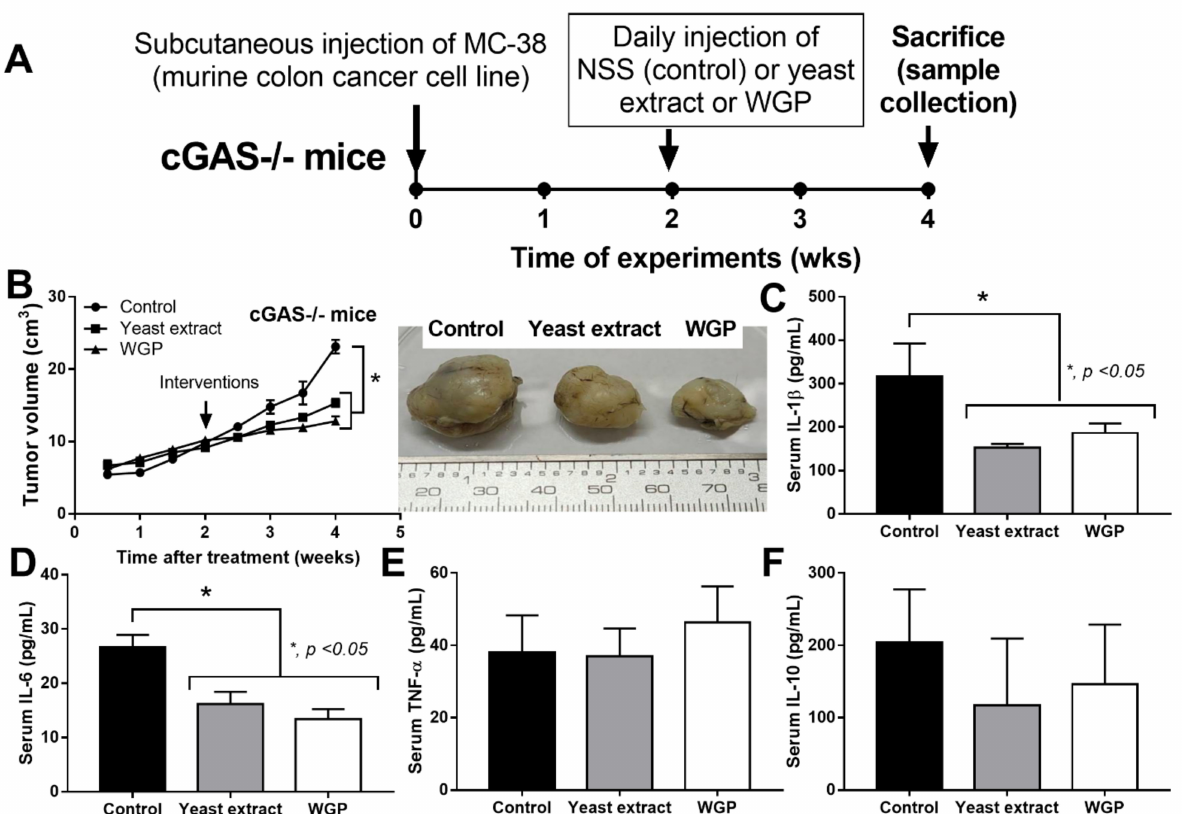
Figure 3. Schema of the experiments of subcutaneous injection of a murine colon cancer cell line (MC38) in cGAS-deficient (cGAS-/-) mice with daily intralesional injection by normal saline solution (NSS) control, crude extract of Saccharomyces cerevisiae (yeast extract), or whole glucan particle (WGP) starting from the 2nd to 4th week of experiments ( A ) with characteristics of the mice as indicated by tumor volume with the representative pictures of the excised tumors ( B ) and serum cytokines (IL-1 β , IL-6, TNF- α , and IL-10) ( C – F ) ( n = 7–8/group). *, p < 0.05. The analysis of time-point data ( B ) and the multiple groups ( C – F ) were determined by repeated measures ANOVA and one-way analysis of variance (ANOVA) with Tukey’s analysis, respectively. The exact p values for ( A , C , D ) are demonstrated in Table